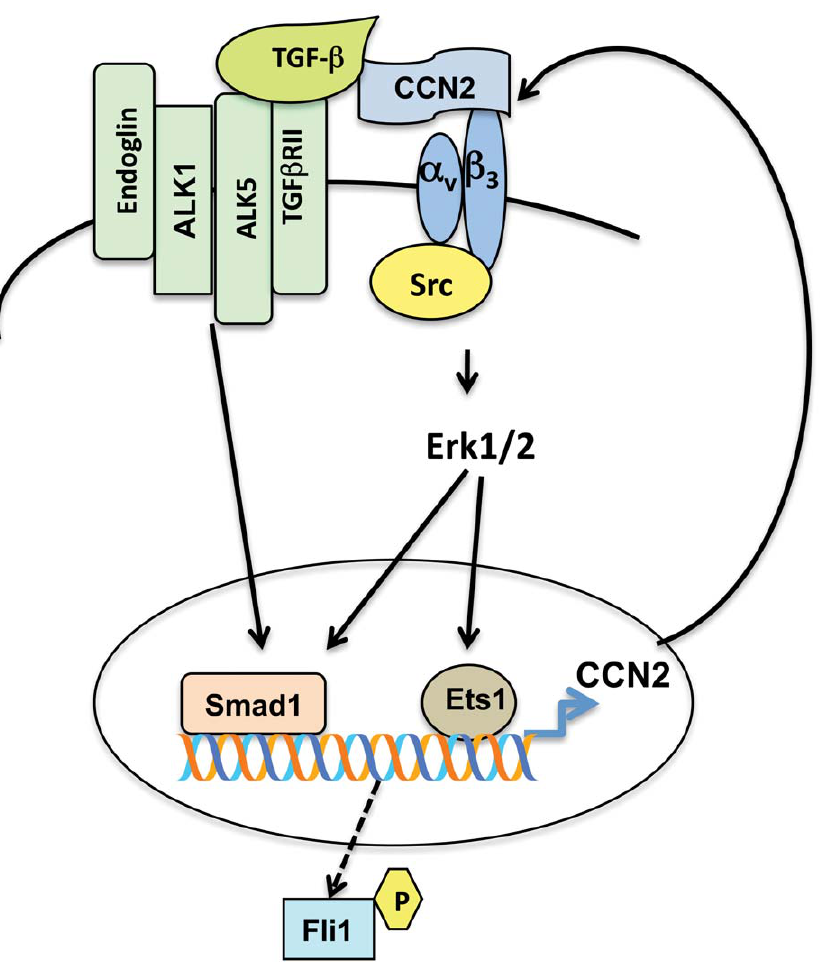
Figure 7. A proposed model for the positive feedback loop between TGF- b /Smad1 and CCN2 pathway. See Discussion text for details.